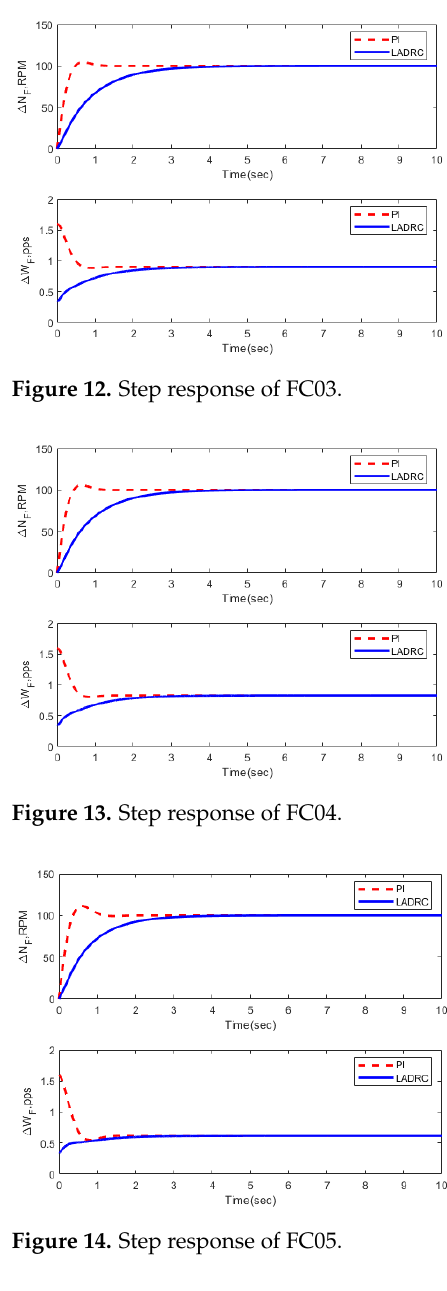
Figure 15. Step response of FC06.